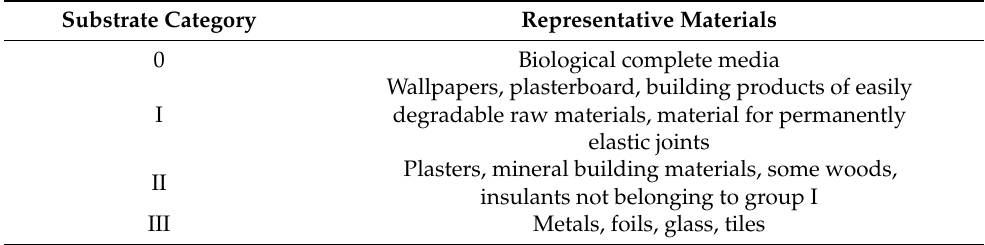
Table 2. Assignment of different materials to substrate categories.